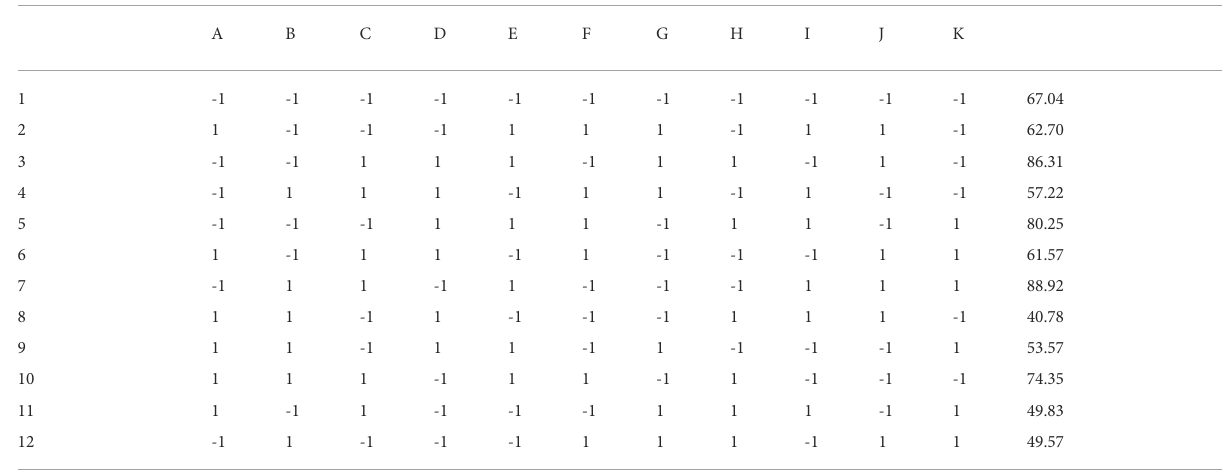
TABLE 3 Plackett-Burman experiment